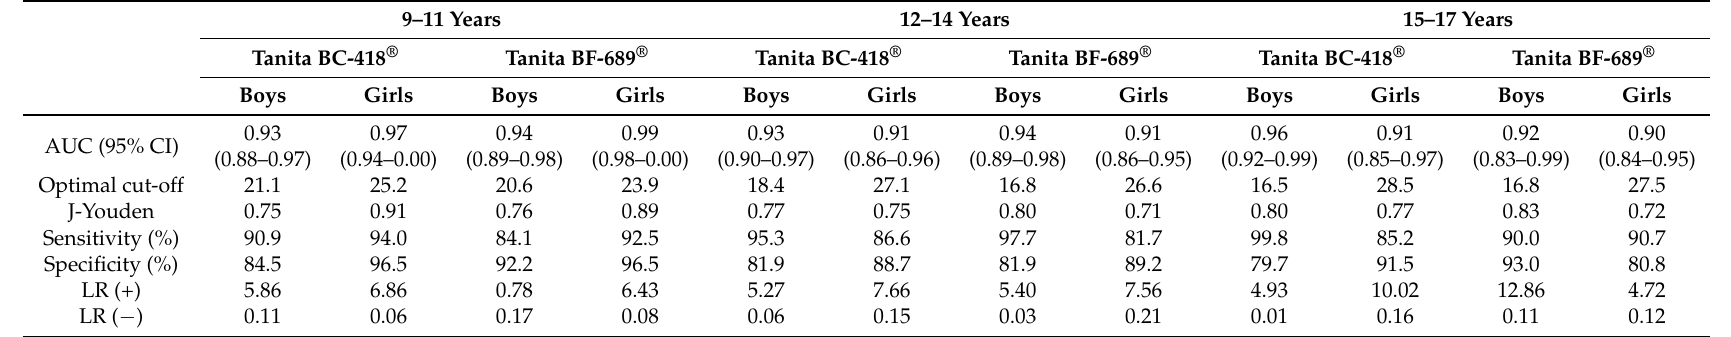
Table 3. Area under the receiver-operating characteristic curves for ability to correctly classify youths as overweight/obesity ( ≥ 2SD) defined by IOTF among Colombian children and